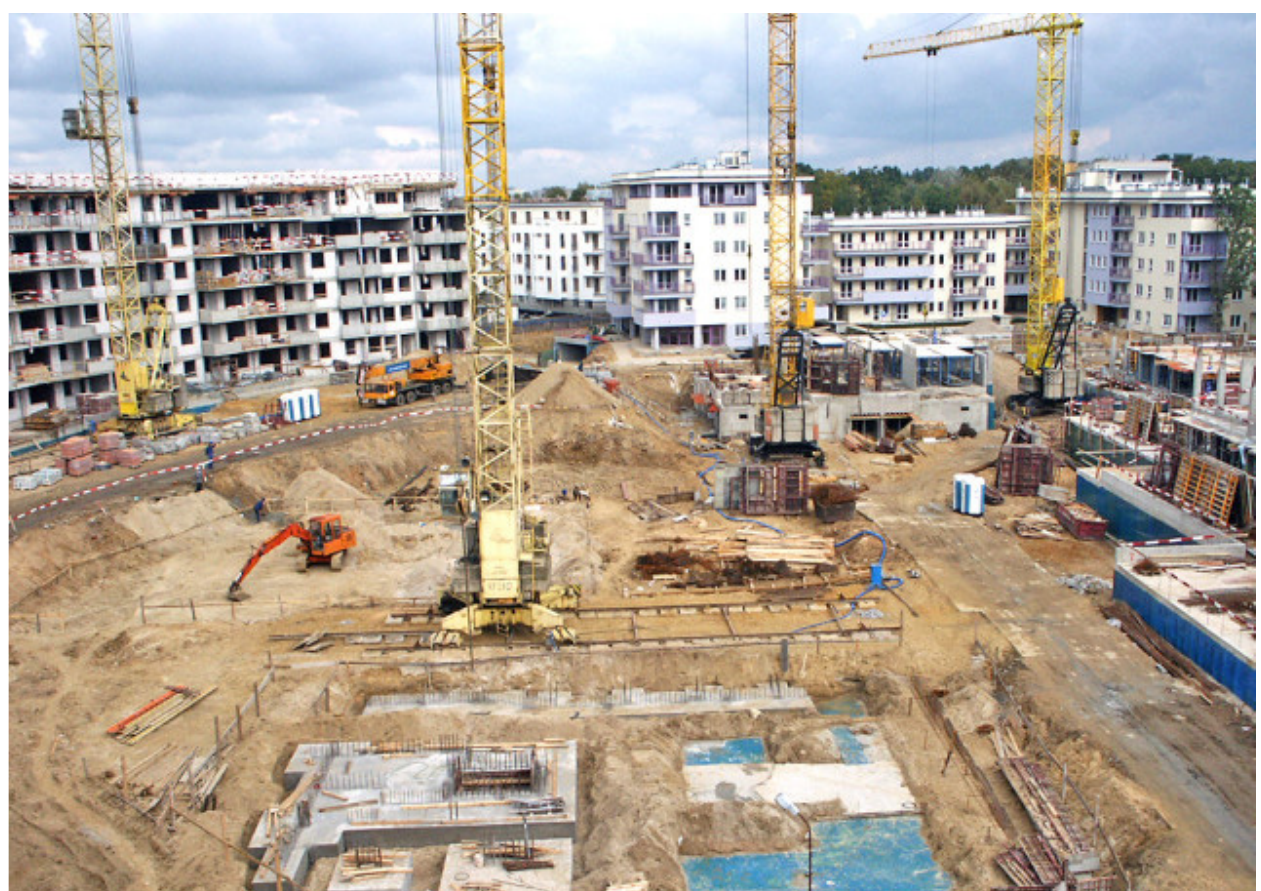
Figure 1. Construction of the Parkowo-Le ś ne housing estate complex—view from the side of Os- ma ń czyk 10 street (construction site, October 2004).